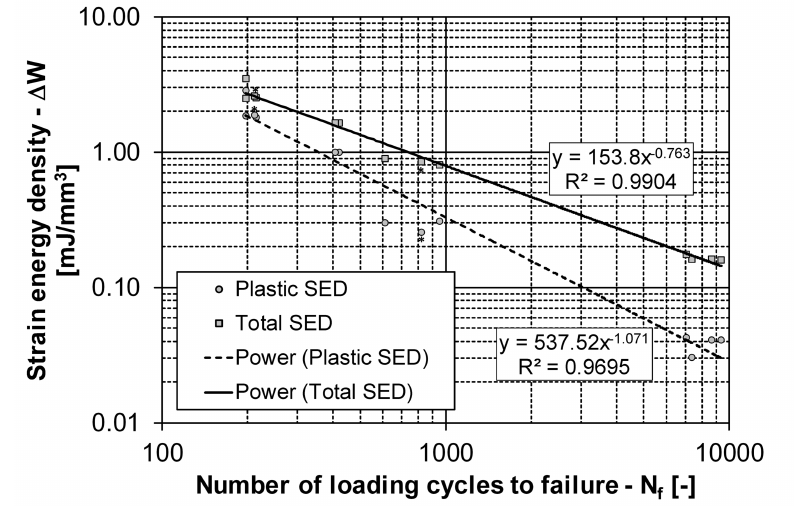
Figure 10. Energy fatigue-life curves: plastic strain–energy density (circles) and total strain–energy density